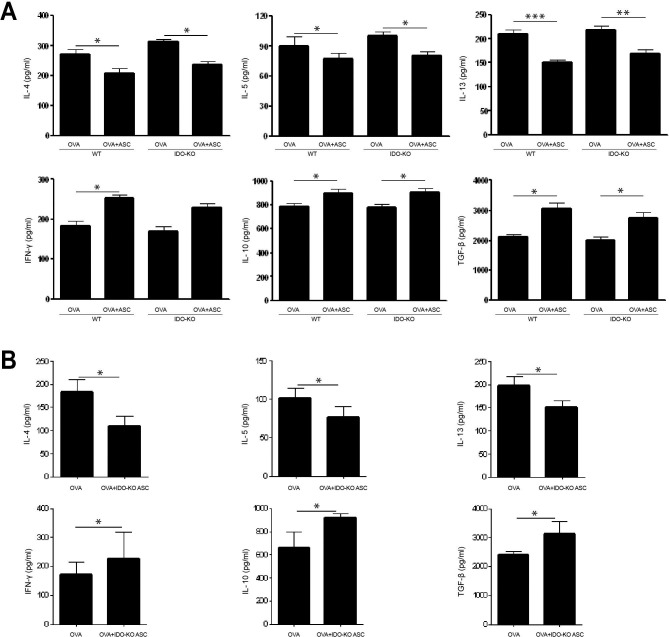
Effect of adipose-derived stem cells (ASCs) on cytokine levels in the lung draining lymph nodes.ASCs (A) or ASCs derived from indoleamine 2, 3-dioxygenase (IDO)-knockout (KO) mice (B) treatment significantly decreased IL-4, IL-5, and IL-13 levels, but increased IFN-γ, IL-10, and TGF-β levels in WT and IDO-KO asthmatic mice. Data are expressed as the mean ± SEM of four independent experiments performed in triplicate. *
p<0.05, **
p≤0.005, ***
p≤0.001.